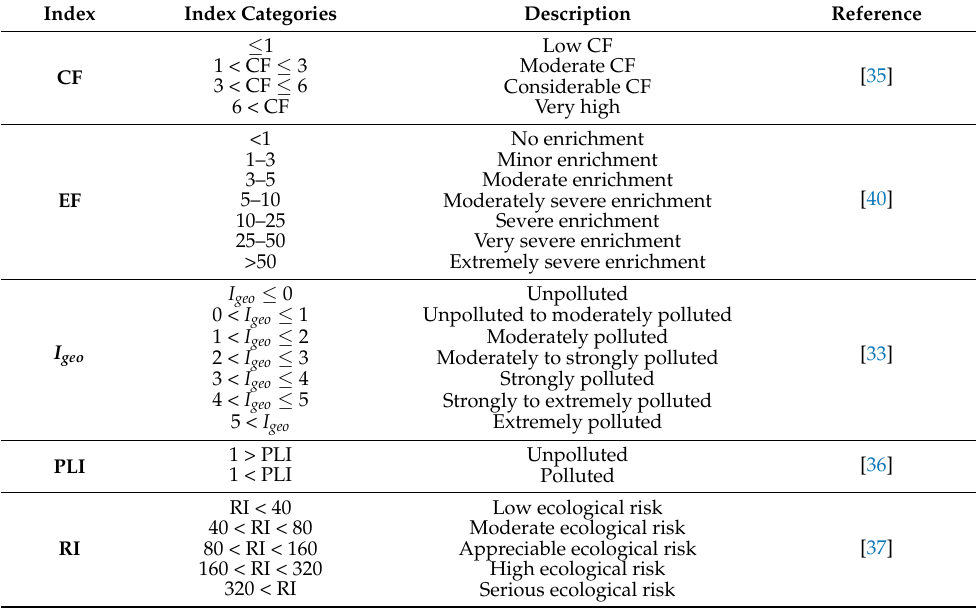
Table 2. Contamination factor (CF), enrichment factor (EF), geoaccumulation index ( I geo ), pollution load index (PLI), and risk index (RI) classes describing the degree of metal concentration in